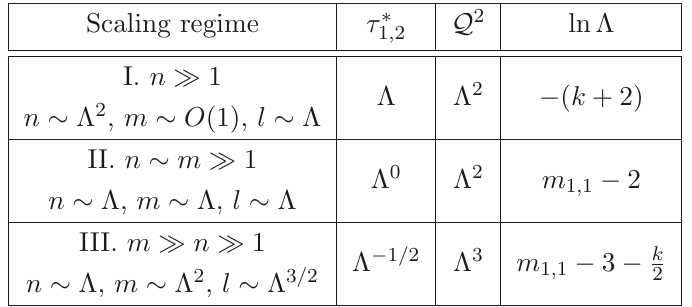
) for SMF built out of weak Jacobi Forms, Q 1 which controls the scaling of ≫ Q